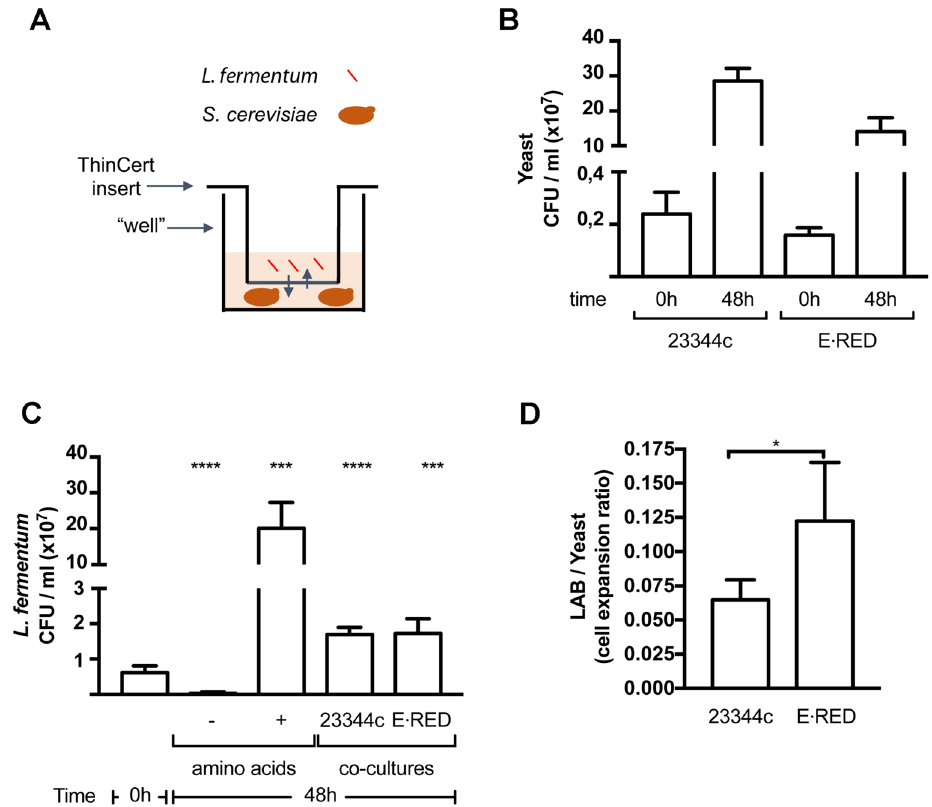
Figure 1. The bioethanol-producing yeast strain Ethanol Red cross-feeds Lactobacillus fermentum . ( A ) Schematic representation of the co-culture system. The yeast cell suspension is placed in the well and the insert prefilled with the L. fermentum cell suspension is placed on top of it. The arrows represent solute diffusion across the membrane separating the two cultures. ( B ) The density of yeast cells in cultures of the wild-type laboratory strain 23344c or the industrial strain Ethanol Red (E ⋅ RED) were monitored by counting colony-forming units (CFUs) just after inoculation (0 h) and after 48 h of co-culture. ( C ) L. fermentum cell density was monitored by counting CFUs in co-cultures with the 23344c wild-type or the Ethanol Red (E ⋅ RED) yeast strain, just after inoculation (0 h) and after 48 h of co-culture. In a control experiment, L. fermentum cell density was assessed after cultivation, in the absence of yeast, in the presence or absence of all 20 amino acids. ( D ) The values presented in ( B and C ) were used to calculate the cell propagation ratio of L. fermentum co-cultivated with 23344c or E ⋅ RED. Bars represent averages of minimum three independent experiments ± standard deviation (SD). * indicates a statistically significant difference as determined with the unpaired t test. * P < 0.034; *** P < 0.0002; **** P <